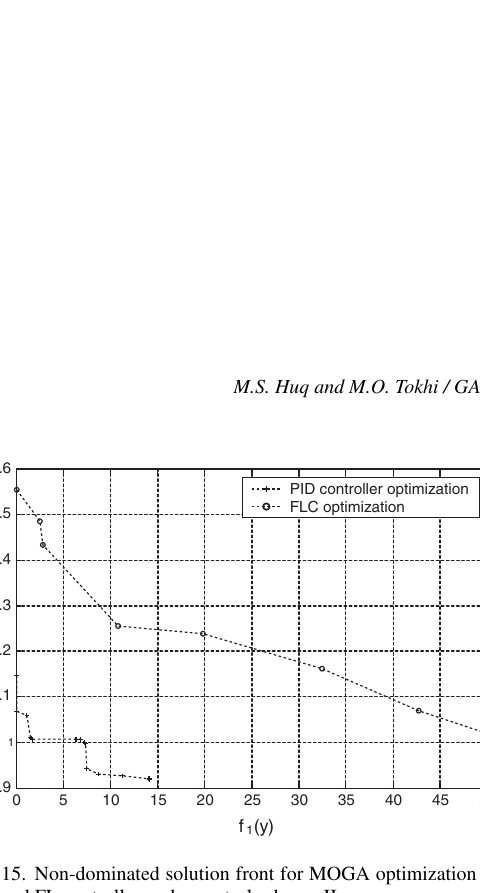
Fig. 16. Knee joint trajectories using PID and FL controller under control scheme-II.